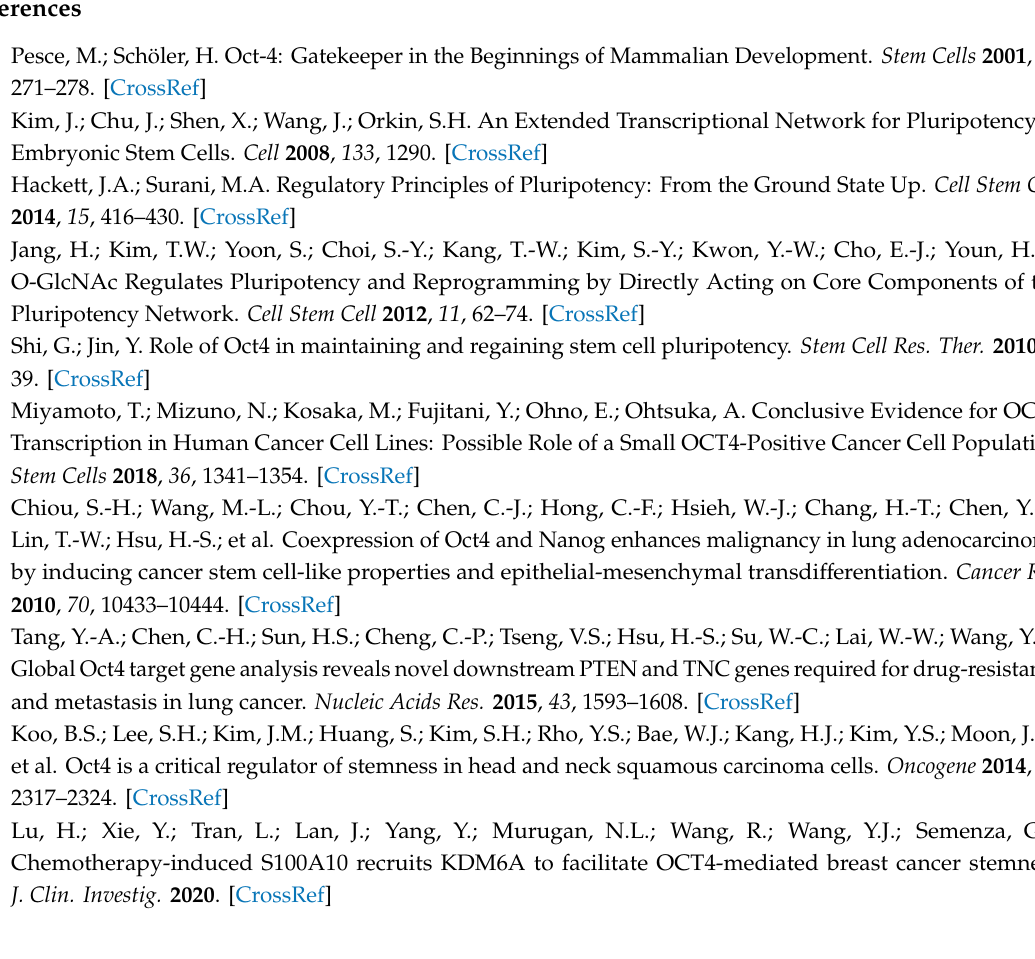
Table S1: Di ff erentially expressed genes among the NCCIT cells harboring endogenous OCT4, depleted OCT4, OCT4 WT rescue, and OCT4 S236D rescue. Figure S1: Immunohistochemistry staining of the same GCT patient sample used in Figure 1A by anti-CKAP2